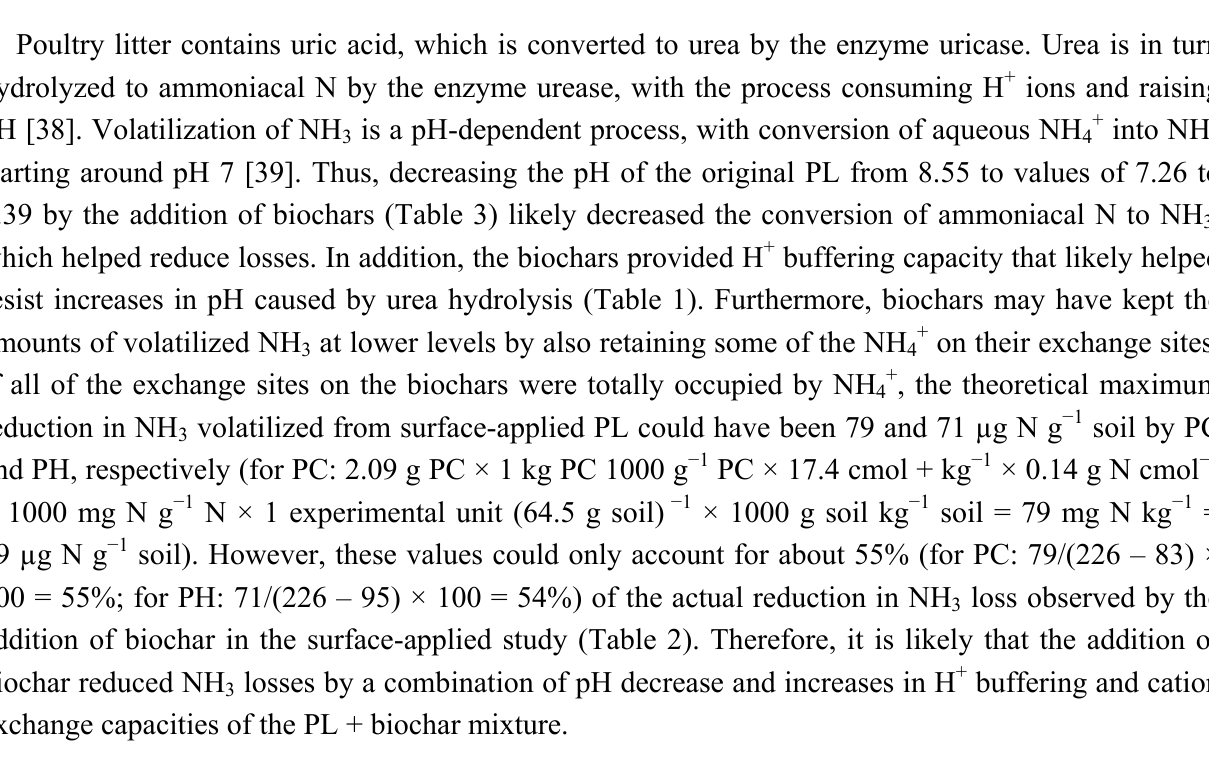
Legend for Table 3: PL refers to poultry litter; PC and PH refer to biochar from pine chips and peanut hulls, respectively. † Within each column, different letters (a,b,c) mean significant difference between treatments at 0.05 level of